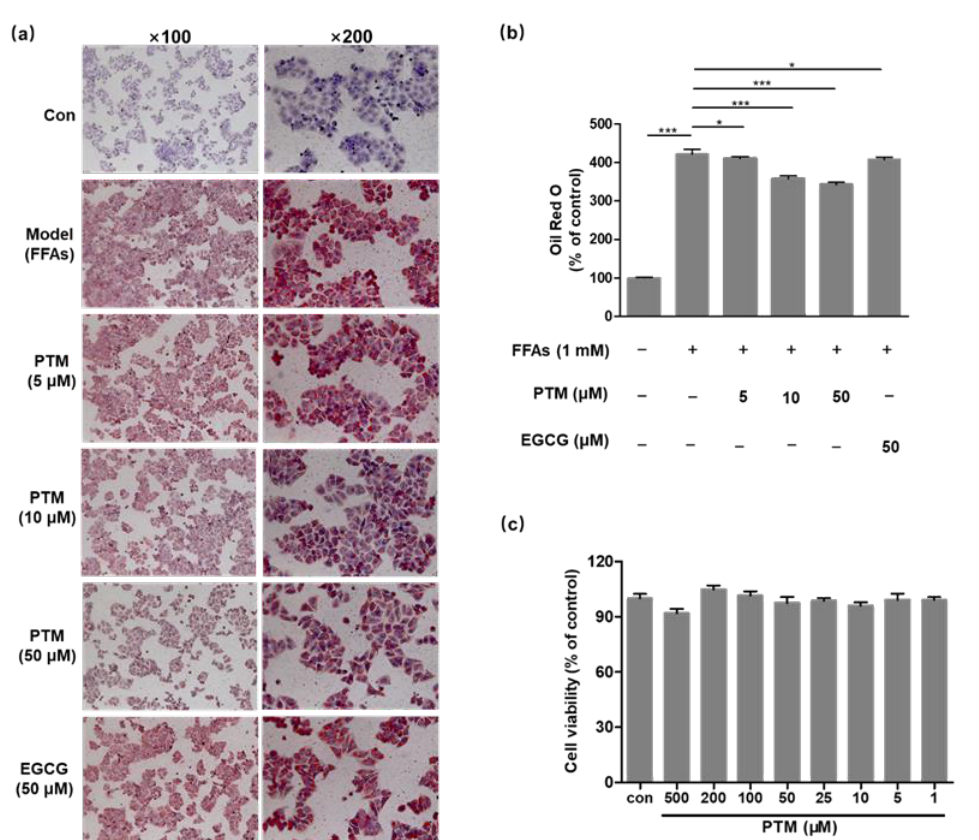
Figure 4. In vitro cytotoxicity and effect of PTM on lipid accumulation. ( a ) Effect of PTM on lipid accumulation in HepG2 cells. ( b ) Lipid content was extracted from Oil red O stained cells by isopropanol and quantified by spectrophotometric analysis at 510 nm. ( c ) Effects of PTM on HepG2 cell viability in response to different concentrations of PTM after incubation for 72 h. Data was visualized by GraphPad software. Error bars represent means ± SD. * p < 0.05, *** p < 0.001.